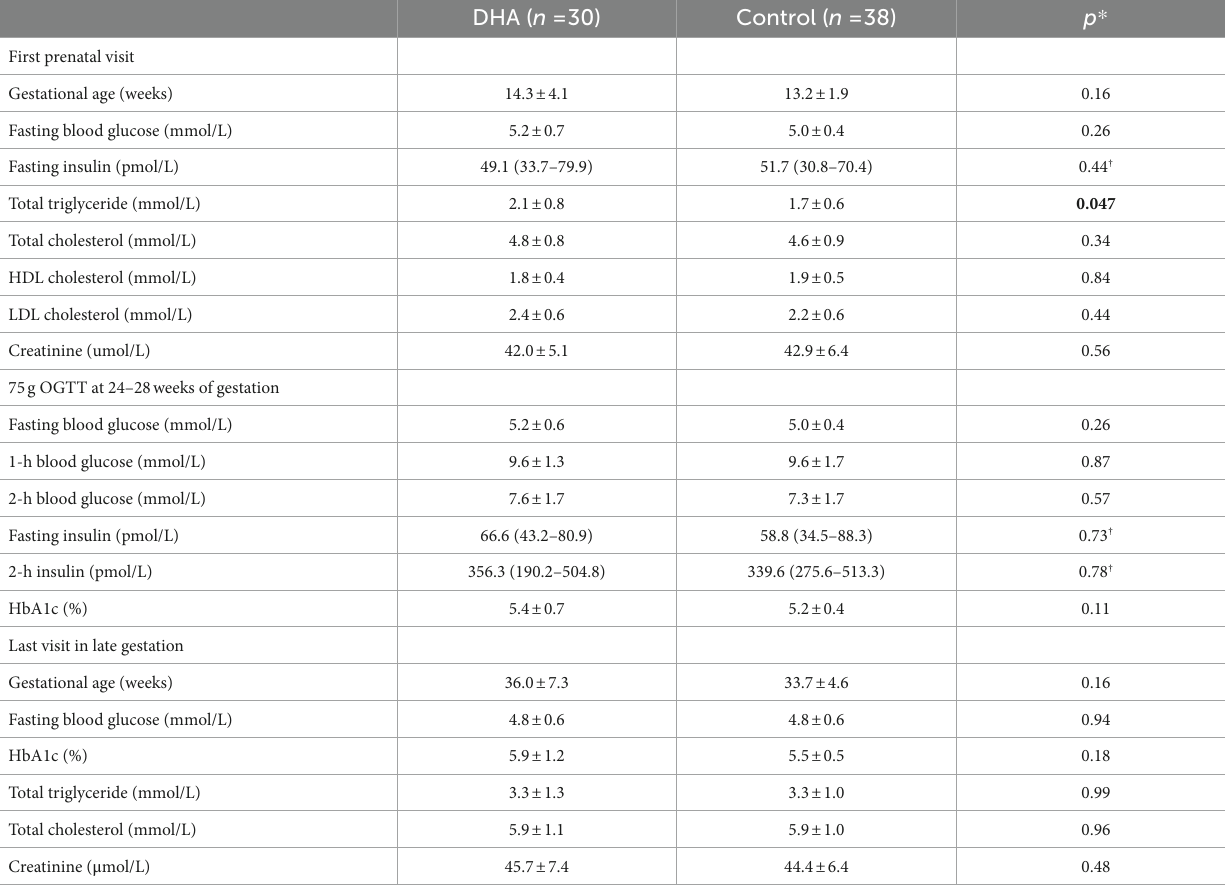
* p Values in t -tests for comparisons between the two groups. † p Values for comparisons between the two groups in log-transformed data for insulin. Data represented are mean ± SD or median (IQR). DHA, docosahexaenoic acid; GDM, gestational diabetes mellitus; HbA1c, glycated hemoglobin; HDL, high-density lipoprotein; LDL, low-density lipoprotein. p Values in bold: p <